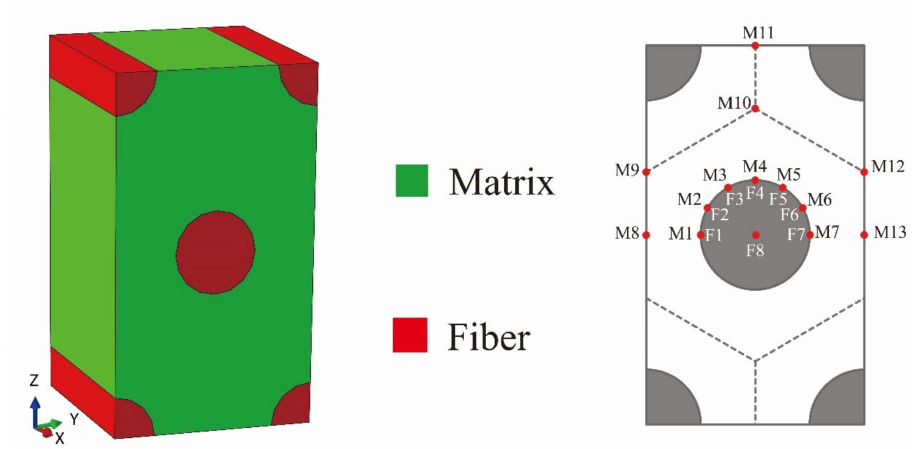
Figure 1. The hexagonal micro-scale RUC and reference points of the constituents.